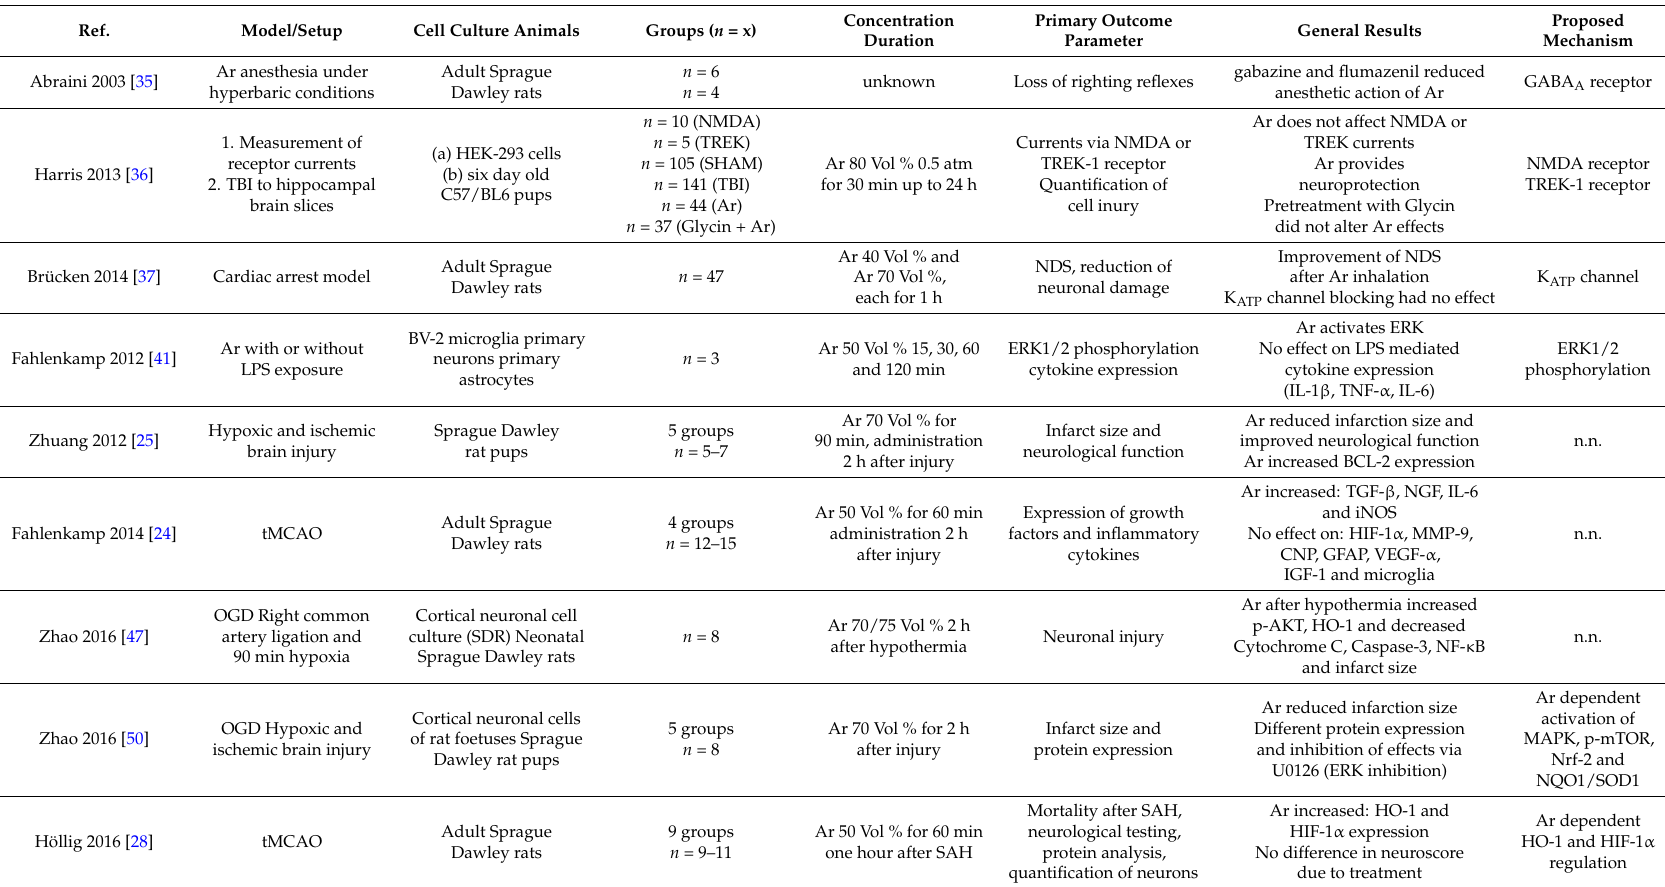
Table 1. Experimental analysis of the molecular mechanism of argon-mediated